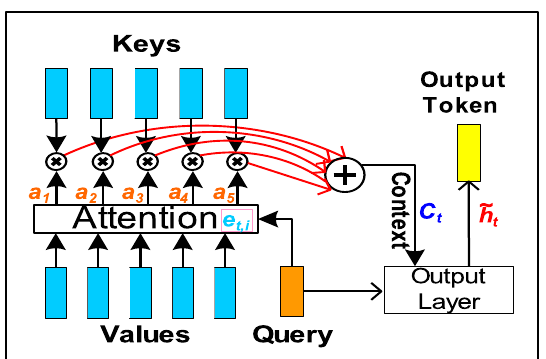
Figure 10. Attention Mechanism (conceptual). Allows the decoder to learn how much influence each Key-Value (input tokens) has on a given Query (target token) dependence which allows accurately predicting next output token. (Note: all subscripts span length of input sequence 1.. N . Above example is just for a specific case where N =